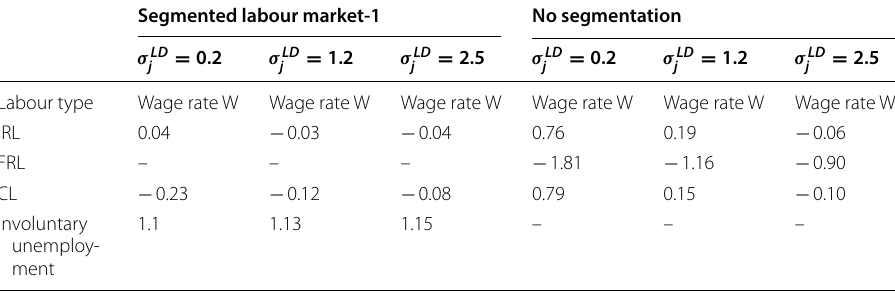
– stands for no change. Sectoral wage rates are not considered in our analysis. In our model set-up we consider economy- wide average wage rates across all